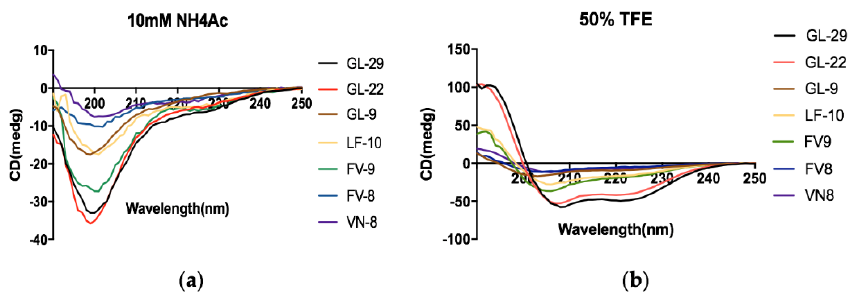
Figure 1. The CD spectra of GL-29 and its analogues in ( a ) 10 mM NH 4 Ac buffer (an aqueous environment) and ( b ) 50% TFE (mimicking the hydrophobic environment of the microbial membrane), respectively.